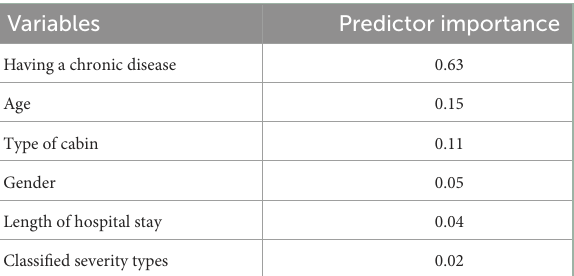
TABLE 2 Predictor importance of Bayesian